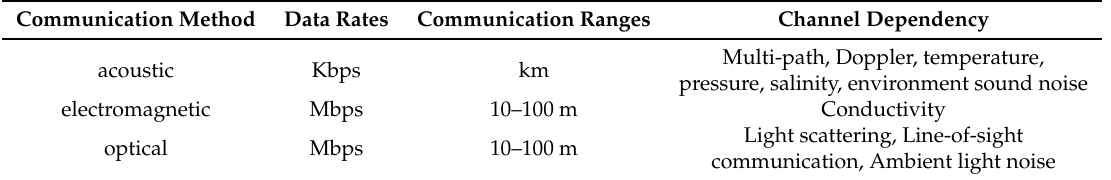
Table 1. Comparison of underwater transmission modes.